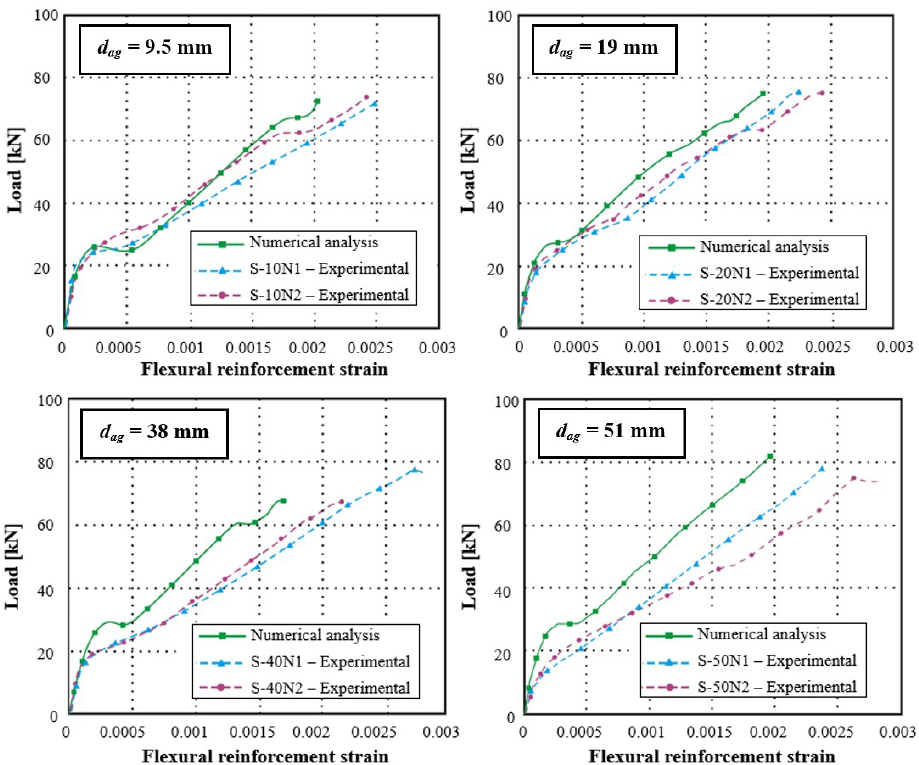
Figure 6. Load versus flexural reinforcement strain curves for S-Series beams.